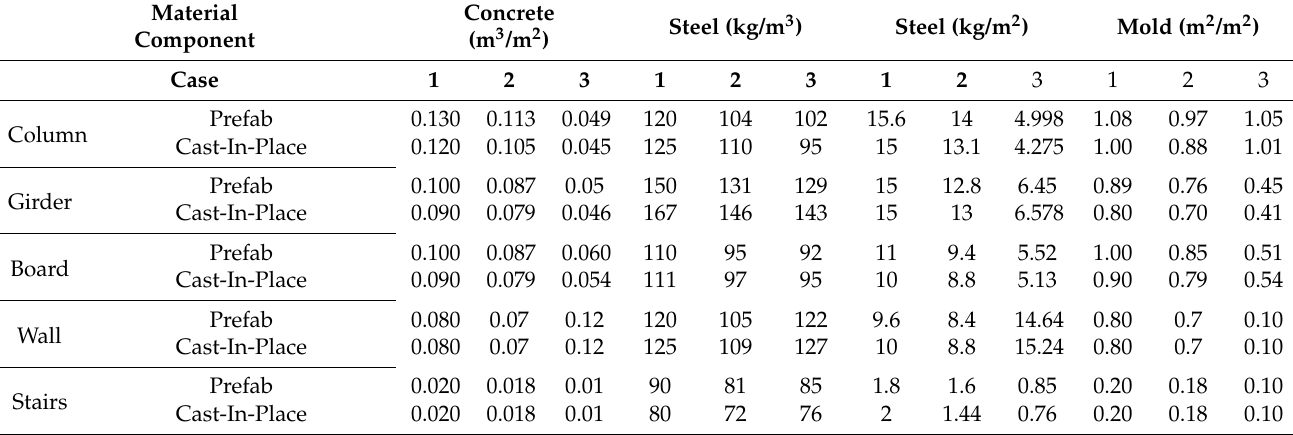
Table 1. List of quantities for structural